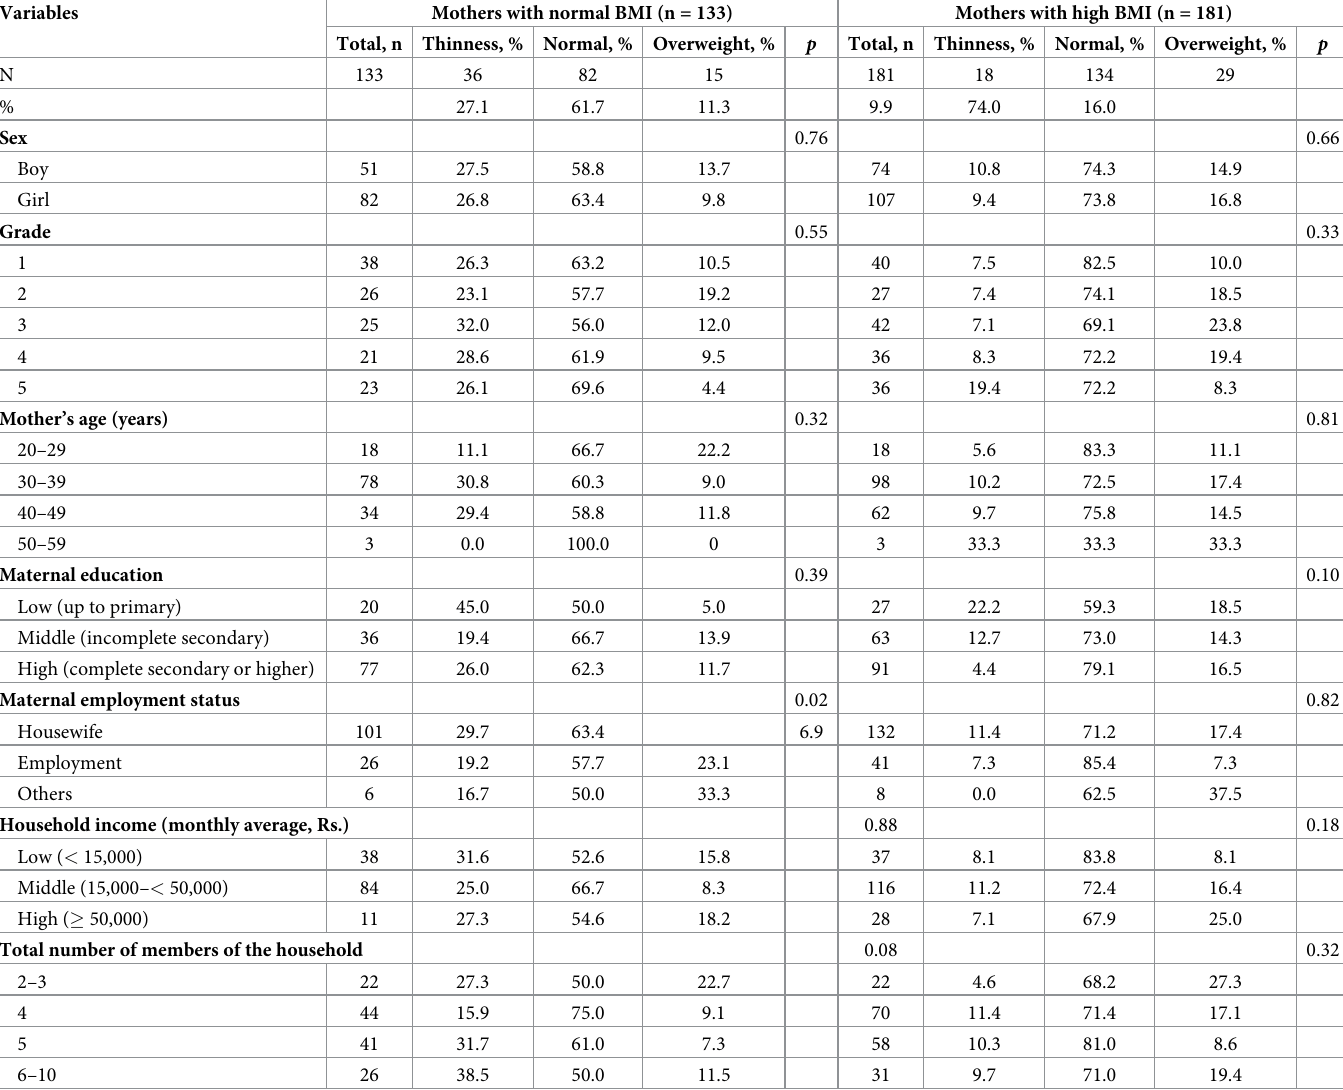
Table 3. Demographic characteristics with nutritional status among mother-child pairs in urban Sri Lanka (n = 314). Variables Mothers with normal BMI (n =